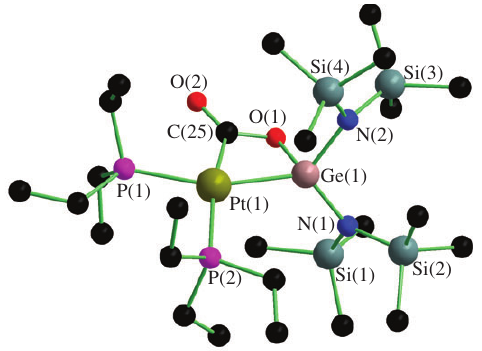
Figure 1 Structure of [Pt(PEt